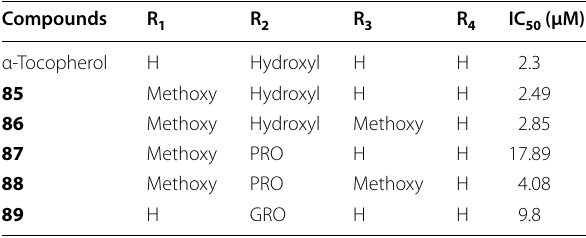
Table 28 Inhibition of DPPH radical by synthesized